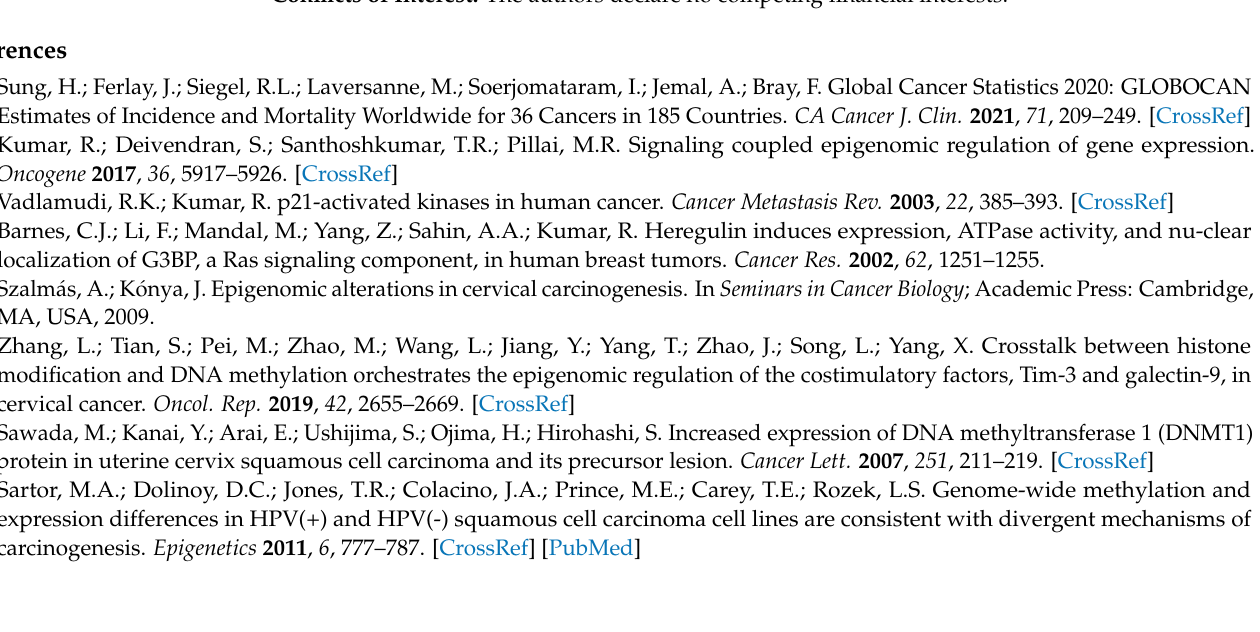
Table S4: Differentially expressed epigenomic regulators in CIN-2/-3 cervical cancer dataset; Table S5: 57 unique epigenomic regulars for cervical cancer when compared to Ovarian and endometrial cancer; Table S6: Fitness score for 55 epigenomic regulators in different cervical cancer cell